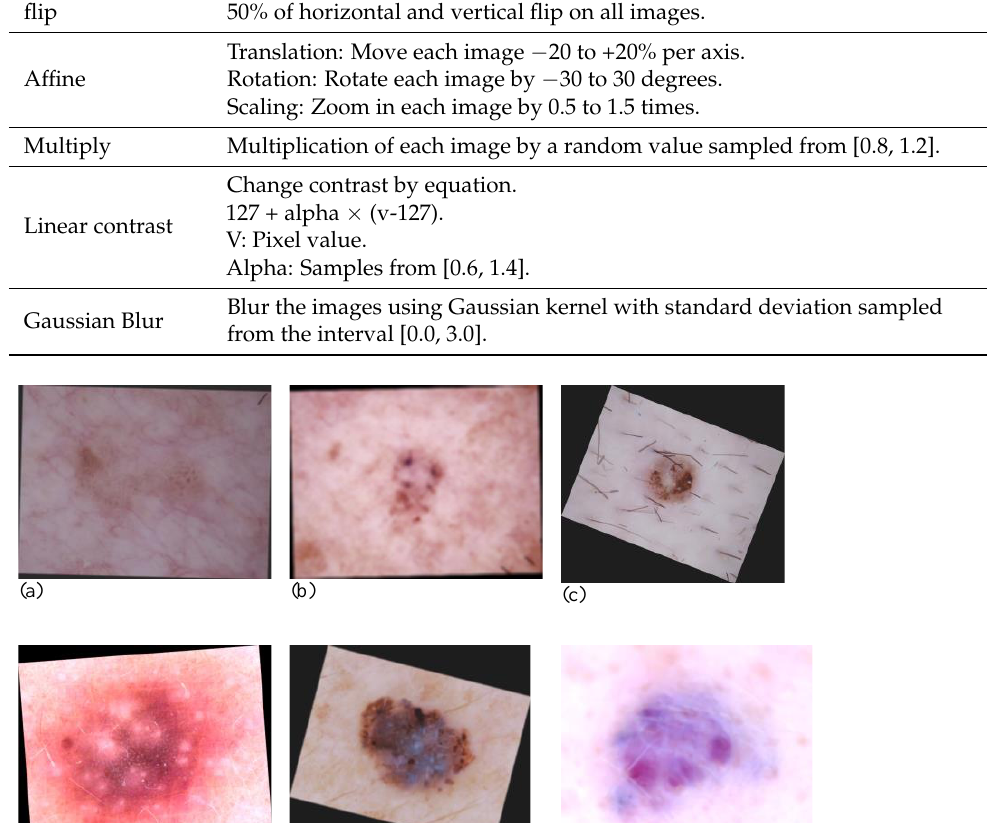
Table 2. Image augmentation techniques.